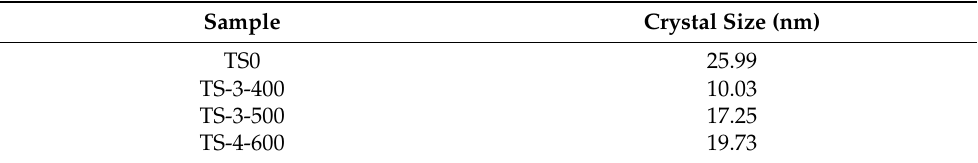
Table 3. Crystal size of